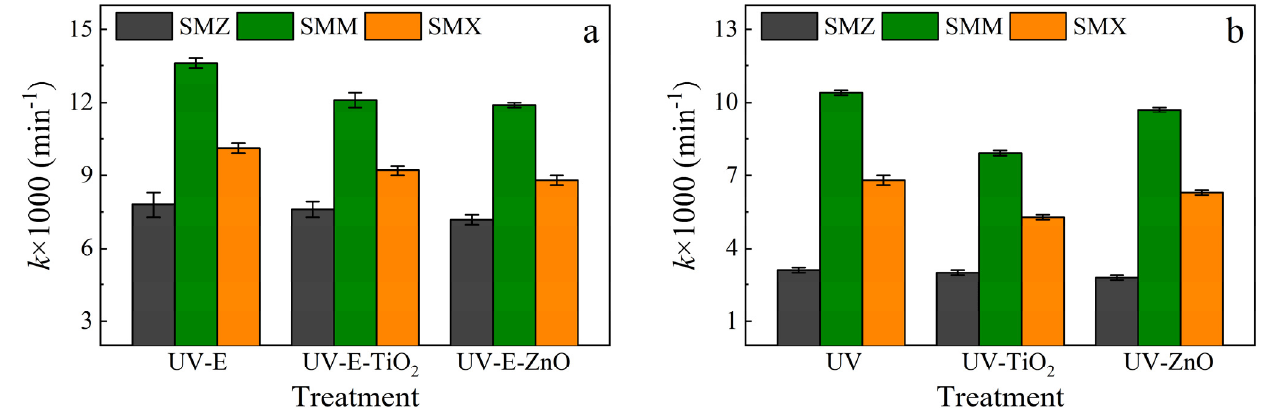
Figure 4. Effects of photocatalysts on sulfonamide degradation. Conditions: Cl − concentration of 50 mg/L, aeration rate of 30 L/min, UV power of 48 W, current of 1.8 A (4.8 mA/cm 2 ), addition of TiO 2 (0.5 g/L) or ZnO (0.1 g/L), and initial pH of 8.3. UV-E: UV irradiation and electrolysis, UV: UV irradiation only, and E: electrolysis only. ( a ). The k value for sulfonamide degradation in UV-E systems. ( b ) The k value for sulfonamide degradation in UV-only systems.